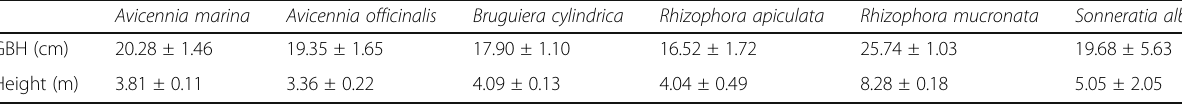
Table 2 Species-wise height and GBH